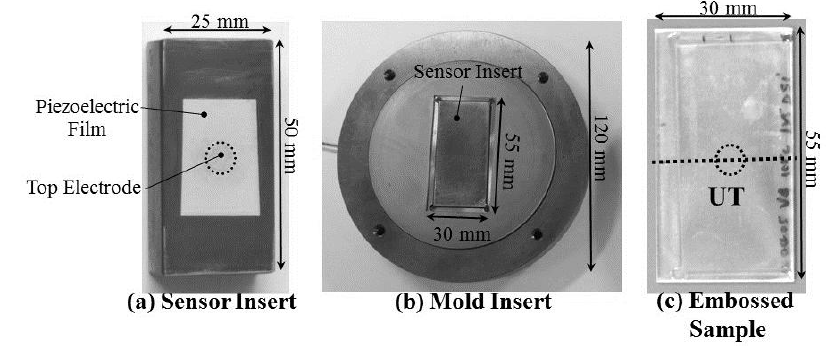
Figure 3. Photographs of ( a ) the sensor insert with HTUT; ( b ) the mold insert and ( c ) the embossed sample with the scanning path denoted by the dotted line passing the UT